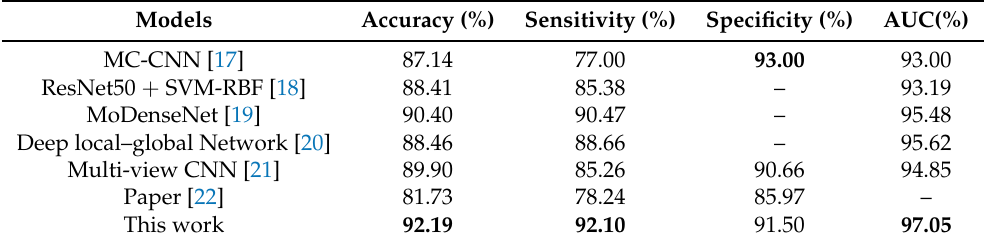
Table 6. Compared with the state-of-the-art methods for binary classification, the best results are in